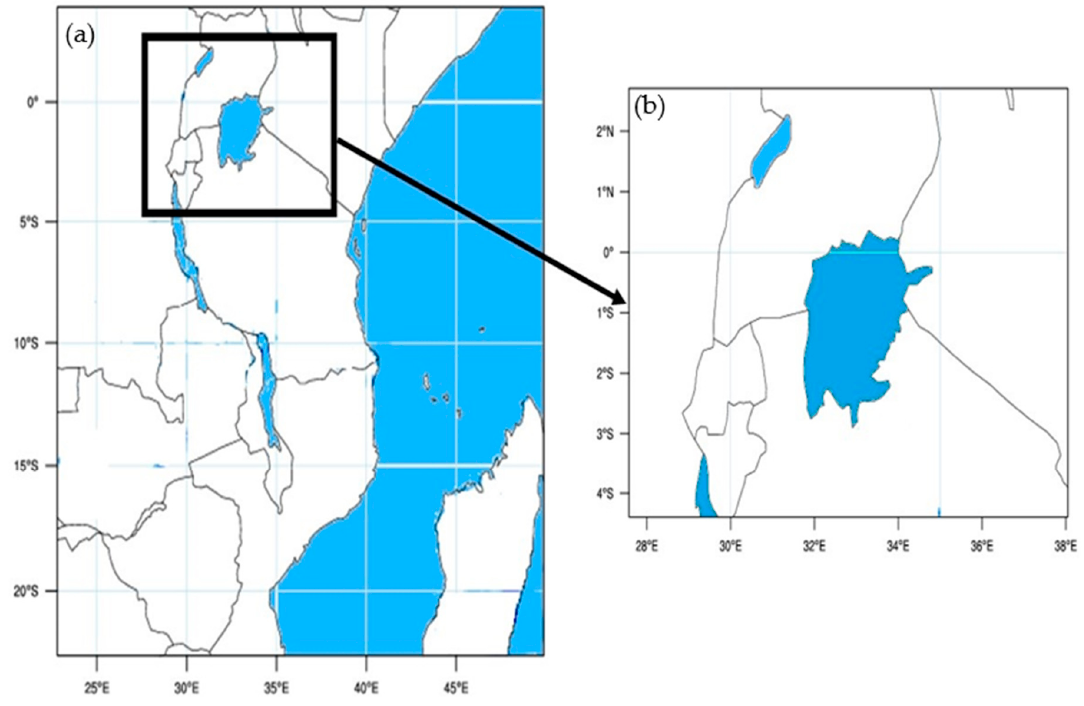
Figure 5. ( a ) Domain 1 (the outer domain); ( b ) Domain 2 (the inner domain, as indicated by the black rectangle in domain 1).